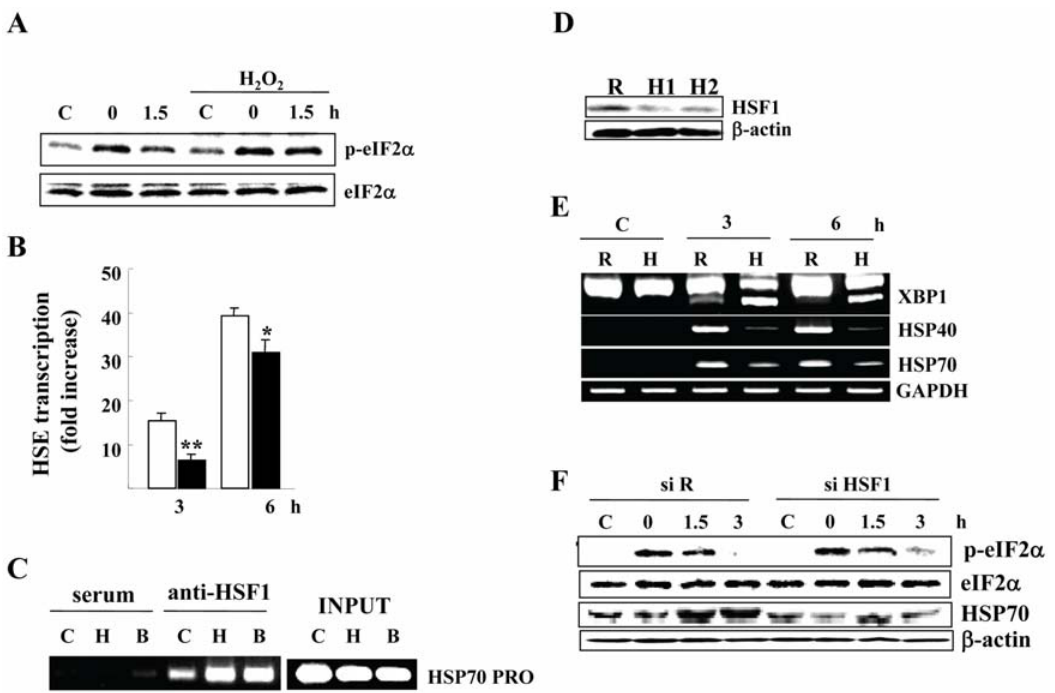
Figure 4. ChIP assay and knockdown of HSF1 transcripts. A ) eIF2 a phosphorylation in A172 cells. At the indicated hours after heat exposure (44 u c for 20 min) with or without 0.25 mM H 2 O 2 pretreatment, eIF2 a activity was evaluated by western blots, and anti-eIF2 a protein antibody shows equal loading of protein samples. B ) Effect of H 2 O 2 pretreatment on HSE transcription. A172 cells were transiently co-transfected with the pHSE and the pRL-TK reporter genes, pretreated with 0.25 mM H 2 O 2 (closed bars), incubated for the indicated hours after heat exposure (43 u c for 20 min), and their transcription activity was evaluated by dual luciferase assays. Bars display the mean 6 S.D. of data from three separate experiments and *, P , 0.05, **, P , 0.01 compared with H 2 O 2 -unexposed cells. C ) Chromatin immunoprecipitation assays. Cells (C; control) were incubated 2 h after heat exposure (44 u c for 20 min) with (B; both) or without (H; heat alone) 0.25 mM H 2 O 2 pretreatment. They were then fixed with formaldehyde, and immunoprecipitated with antibodies against HSF1 (anti-HSF1) or nonimmunized rabbit serum (serum). Immunoprecipitates were amplified by HSF1 promoter primers. A fixed portion of the total input was also examined by PCR (INPUT). D ) HSF1 knockdown. Total cell lysates were harvested 36 h after transfection with siRandom (R) or two different siHSF1 (H1 and H2). E ) XBP1 splicing. Total RNA was prepared from cells transfected with siRandom (R) or siHSF1 (H; H1). After transfection, cells were exposed to heat (44 u c for 20 min) and incubated for the indicated hours. The indicated transcripts were evaluated by RT-PCR. GAPDH mRNA levels ensure that the RNA was correctly quantified. F ) eIF2 a phosphorylation. After exposure to heat (44.5 u c for 20 min), eIF2 a phosphorylation and HSP70 expression were evaluated by western blots. Anti-eIF2 a protein antibody (in A and F ) and anti- b -actin antibody (in D and F ) show equal loading of protein